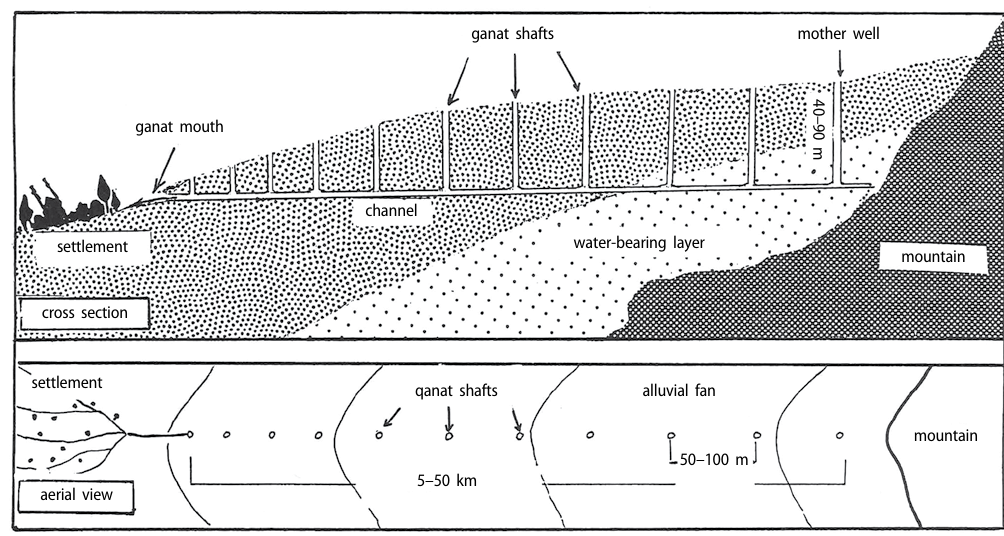
fig. 3. Qanat structure, schematic section. Source : Kheirabadi, M. 2000. Iranian Cities: Formation and Development . Syracuse: Syracuse university